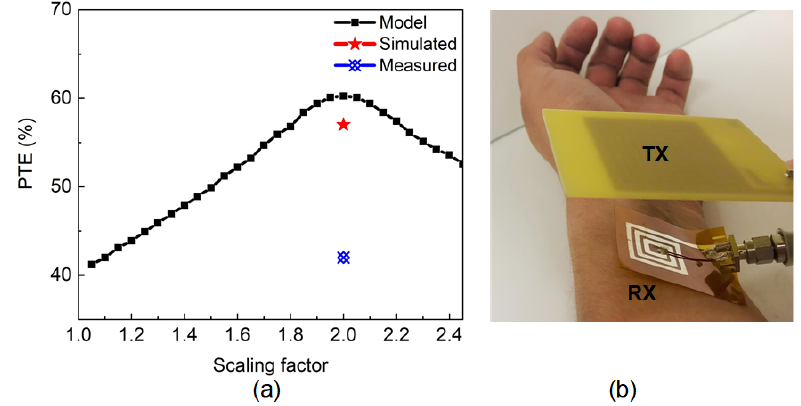
Figure 8. ( a ) Modeled, simulated, and measured PTE with the skin contact. ( b ) Test set-up for the measurement of PTE with the skin